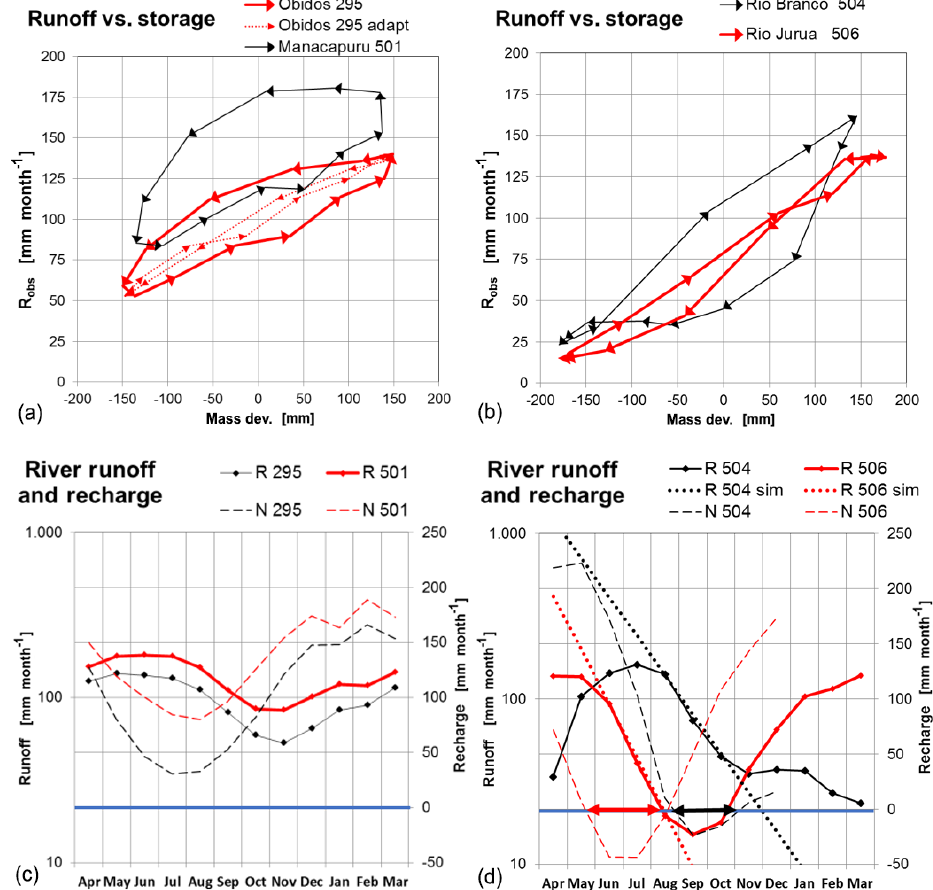
Figure 1. (a) R – S diagram with counter clockwise hysteresis for mean monthly observed runoff R o versus GRACE d M for fully humid catchments including a phase adaption for the Amazon upstream from Obidos (Riegger and Tourian, 2014). (b) R – S diagram with clockwise hysteresis for mean monthly observed runoff R o versus GRACE anomaly d M for seasonally dry catchments in the Amazon basin (Riegger and Tourian, 2014). (c) Mean monthly runoff R and recharge N for fully humid catchments in the Amazon basin (log scale for R ). (d) Mean monthly runoff R and recharge N for seasonally dry catchments in the Amazon basin (log scale for R ) including exponential fittings for runoff R sim